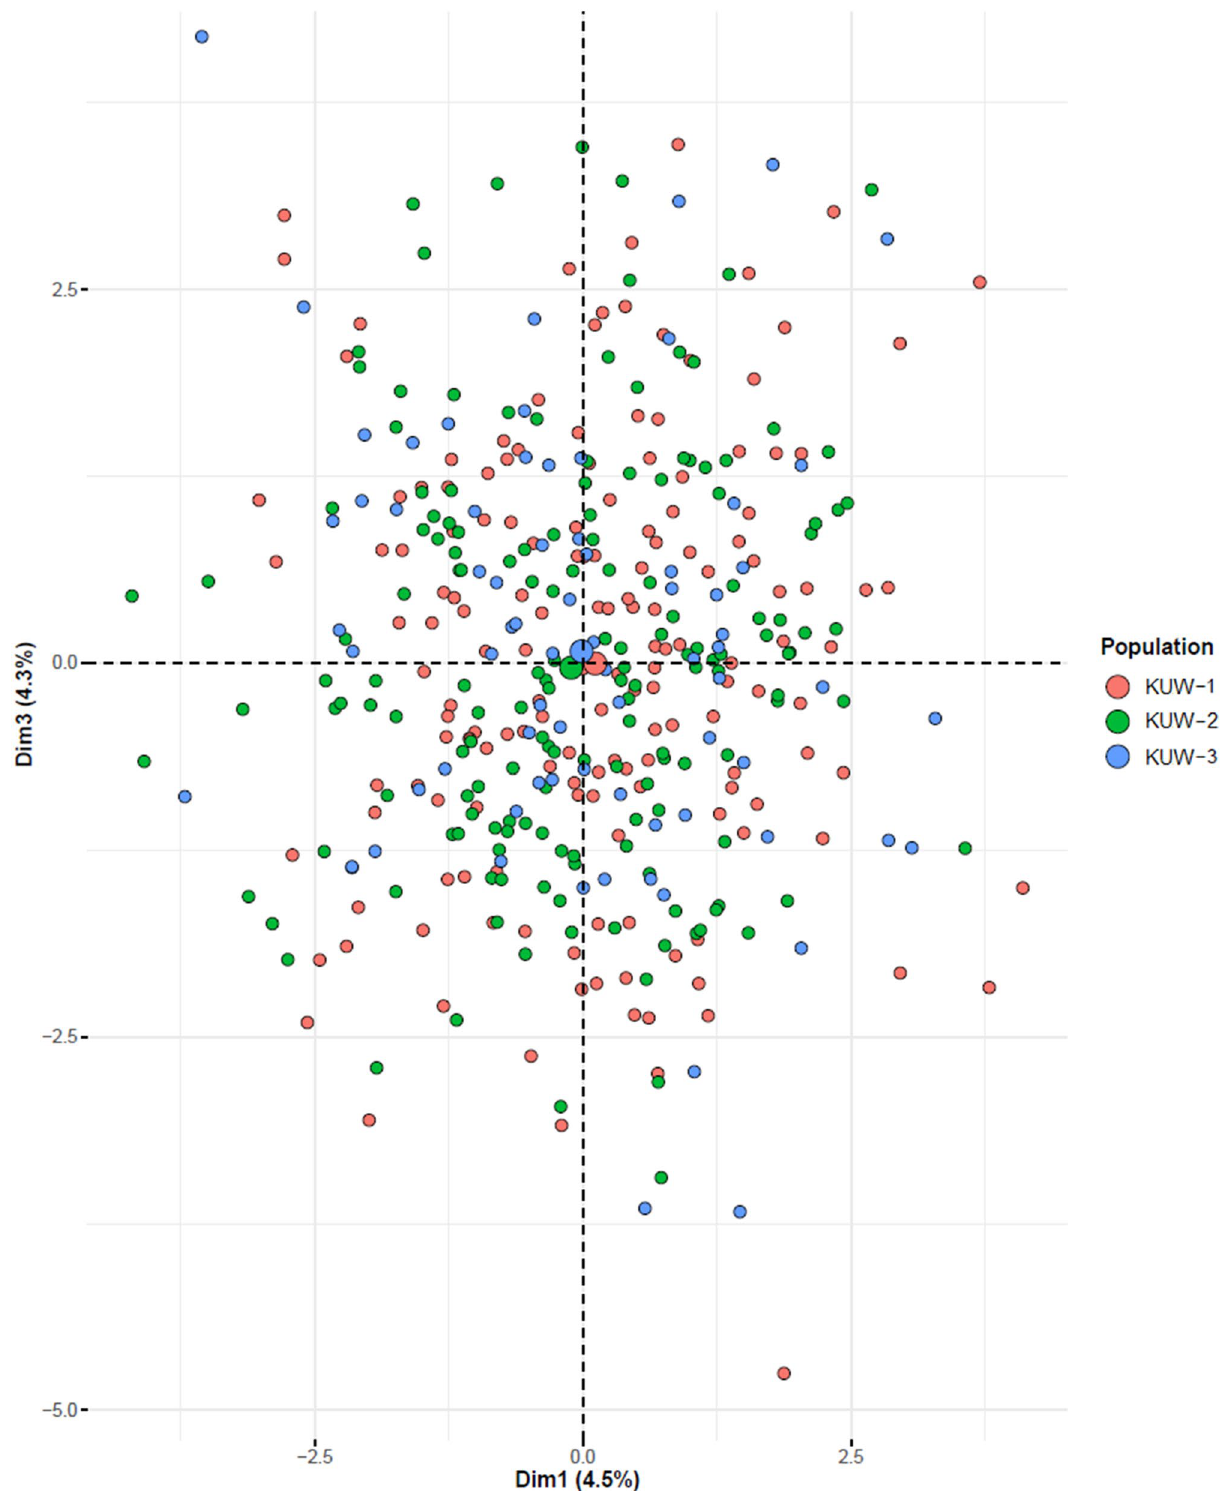
Figure 1. Principal component analysis (PCA) plot showing samples from 400 individuals from the Kuwaiti population, typed for the 23 autosomal STR markers in the PowerPlex Fusion 6C kit. The samples were colour- coded based on their subpopulation of origin KUW-1 to KUW-3. The size of the point represents the number of samples (generated using factoextra package 34 in R software 33